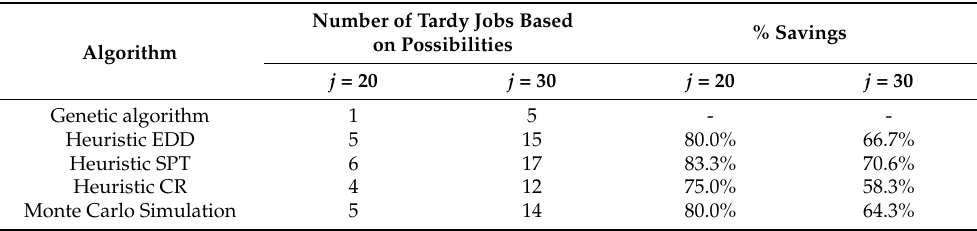
Table 5. Number of tardy jobs for the GA compared to the benchmarks.